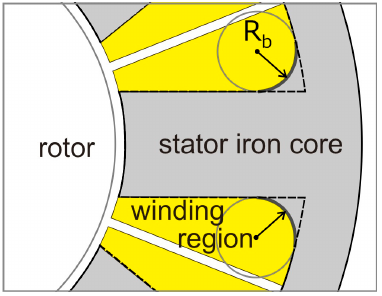
Figure 1. Core loss reduction by attaching the corner radius R b to the tooth root.